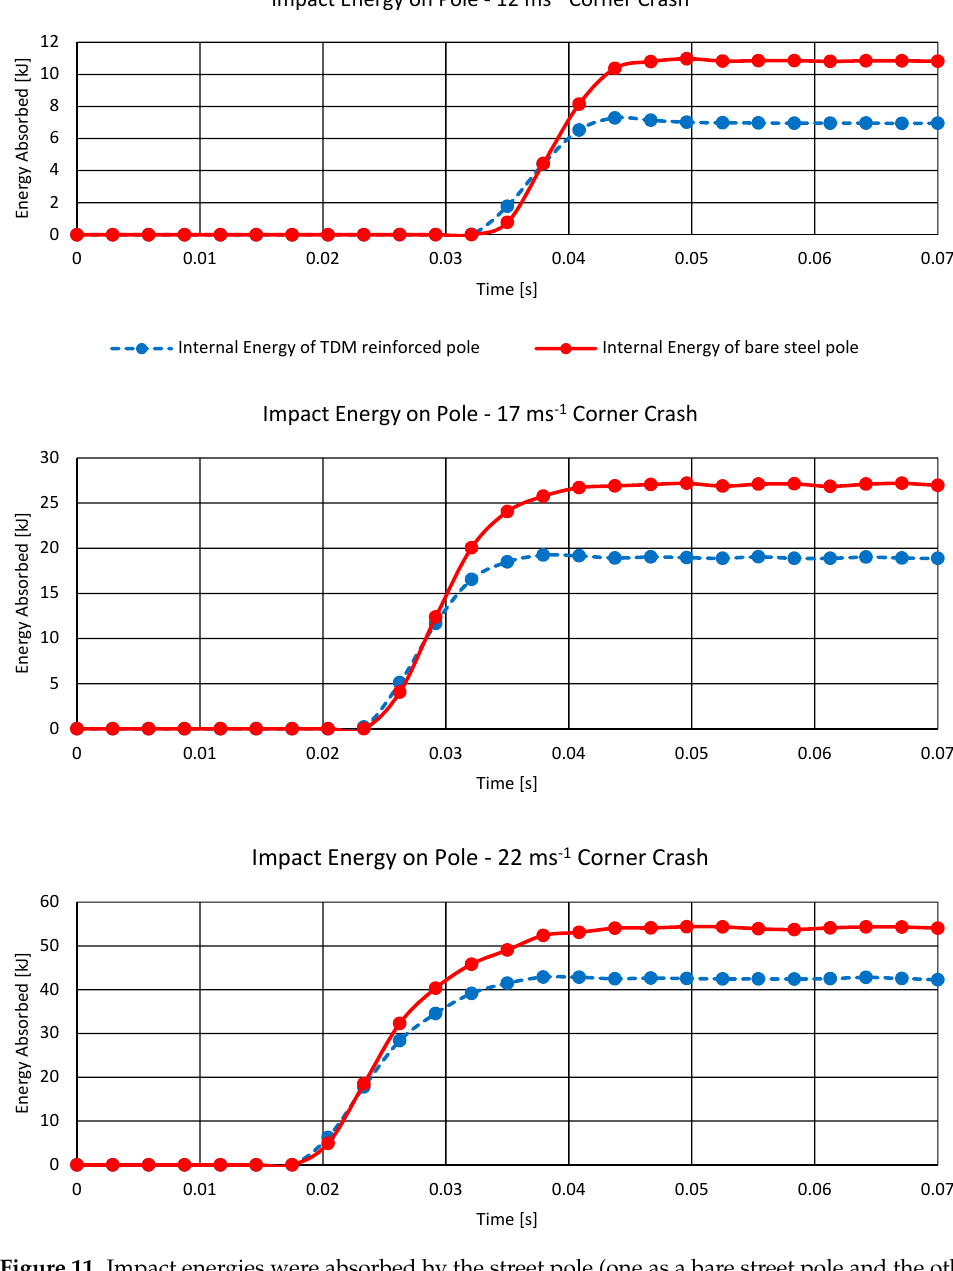
Figure 11. Impact energies were absorbed by the street pole (one as a bare street pole and the other shielded by TDM material of 35 mm) when collided by the vehicle through a corner collision scenario at speeds of 12 ms − 1 , 17 ms − 1 and 22 ms − 1